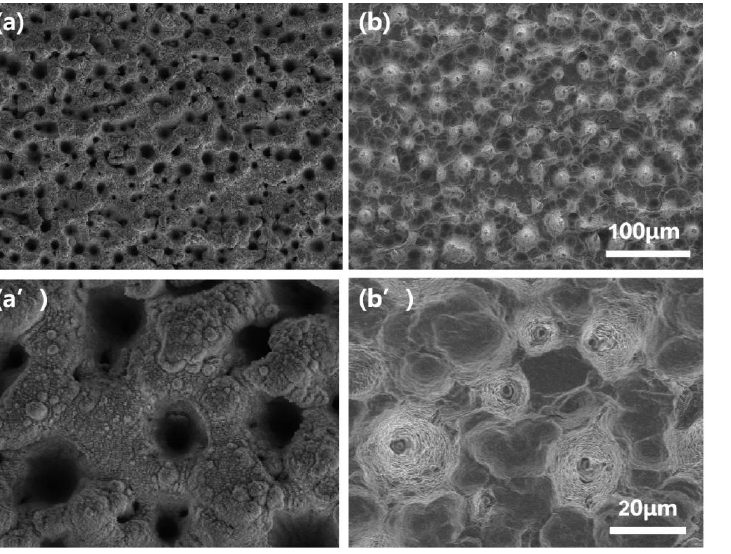
Figure 2. ( a , a’ ) The top-view SEM images of the filament-processed silicon mold surface under low and high magnifications. ( b , b’ ) Differently magnified SEM images of the fabricated MXene-based PDMS film